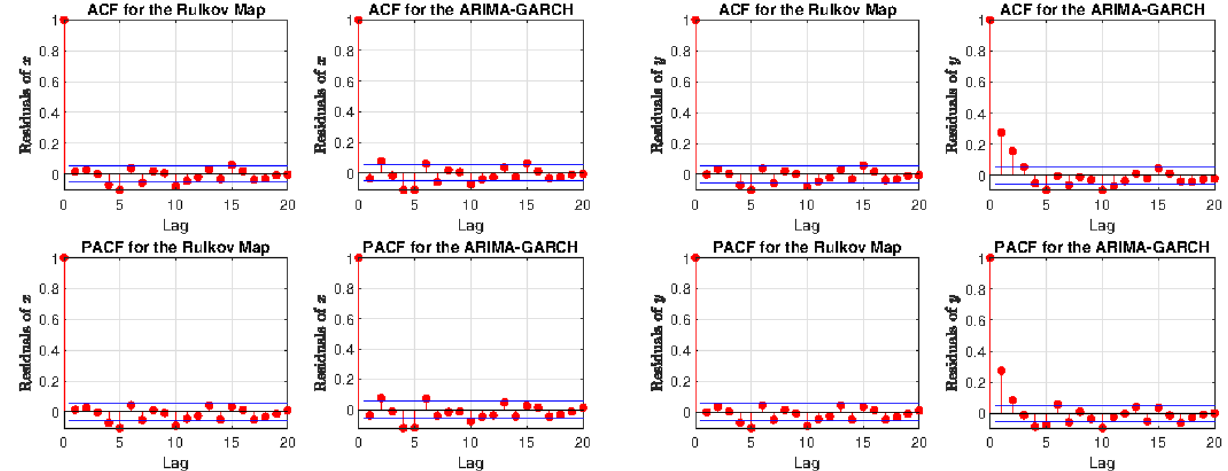
Figure 5. Autocorrelations ACF and partial autocorrelations PACF for state variables x (first two columns) and y (last two columns), comparing the Rulkov map to ARIMA-GARCH ∗ (ARIMA(2,1,2)-GARCH(1,1)). While autocorrelation is almost absent in the Rulkov map, the ARIMA-GARCH ∗ displays significant autocorrelations. This could be taken as an indication of the greater explanatory power of the deterministic approach.